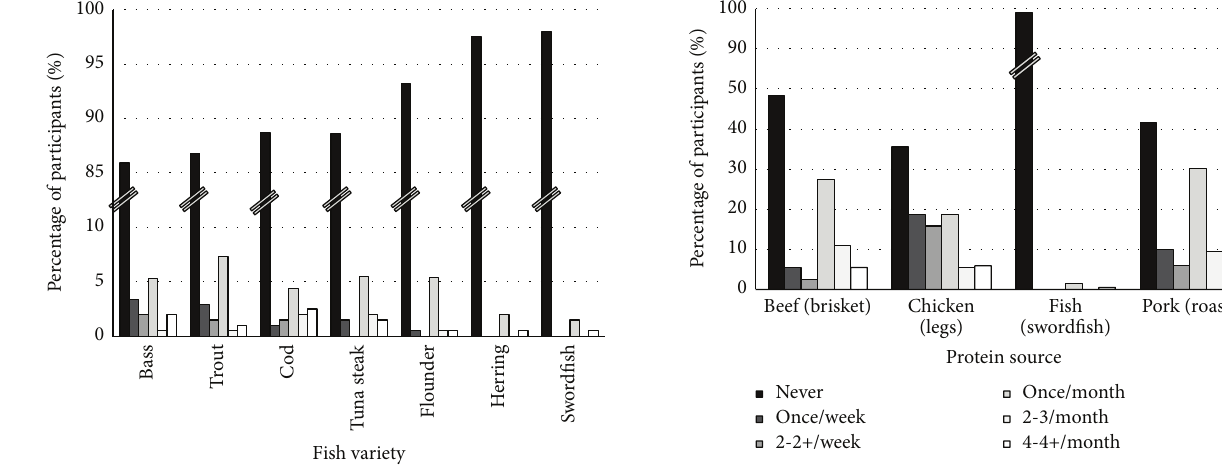
Figure 5: Consumption rate and frequency of the least consumed foods for each protein source by pregnant